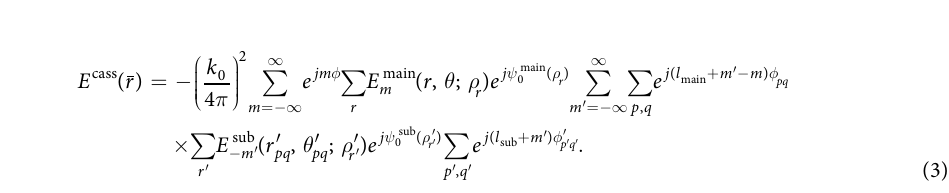
 − φ     ∑ ∑ ∑ ∑ = θ ρ r   π ( ) ( ) ∑ ∑ × ′ ′ ′ . θ ρ sub ρ and ρ ′ Here, φ and φ ′ ′ ′ are progressively changed along the azimuth for the given , respectively. According p q pq ′ r r to Equations (2) and (3), we conclude that the dominant total OAM mode number of the Cassegrain = + ′ and dual-reflectarray antenna is arithmetically combined, the reason for which is that only m l m main ′ = − m l remain un-canceled owing to Equation (2). Therefore, EM waves doubly-reflected by the reflectarrays sub as show the combined total OAM mode number l tot = − l l l , (4) tot main sub where the minus sign indicates that the main and sub-reflectarrays face each other. Figure 3 shows the simulated and measured near-field magnitude and phase distributions of the Cassegrain dual-reflectarrays with = ± l 0, 1 , when the OAM mode number of the main reflectarray is fixed at = + l 1 . sub main In Fig. 3, the distinct OAM mode-combined patterns indicate that the OAM mode numbers shift from = + − l 1, 0, 1 = + + , as expected from Equation (4). Figure 4 also shows the near-field patterns to l 0, 1, 2 sub tot of = + − l 1, 0, 1 generated only by the sub-reflectarray and horn feed. Microstrip patch elements on the sub sub-reflectarray are configured by Equation (1) to reflect the desired OAM mode l sub . In the next step, the near-fields in Fig. 4 are again reflected by the main reflectarray with = + l 1 , and the resultant field distribu- main tions are then as illustrated in Fig. 3. Based on the near-field to far-field transformed radiation patterns (see Figs 6 and 7 in the Supplement for the corresponding far-field patterns), the normalized OAM modal magnitudes in the far-field radiated from the mode-combined reflectarrays are as shown in Fig. 5. A normalized OAM modal mag- nitude, which also represents the OAM mode purity in the far-field, is defined as θ θ | | F F ( )/ ( ) ml ( ) , where a far-field ml jm far ( ) θ φ θ = ∑ φ =−∞∞ . As shown in Figs 3 and 5, the mode-combined radiation pattern is expanded by E F e ( , ) ( ) m OAM states ( l ) in the near-field are continuously conserved in the far-field, thereby confirming that Equation tot (4) is satisfied even in the far-field including the near-field. Consequently, Figs 3 and 5 indicate that the OAM modes of the EM fields can be arithmetically added or subtracted in both the near- and far-fields. The OAM mode-combining phenomenon also exists in a Cassegrain dual-reflector configuration (see the Supplementary = − and l 1 = + are selected for the heli- Measurement of a Cassegrain Dual-reflector Antenna). When l 1 main sub